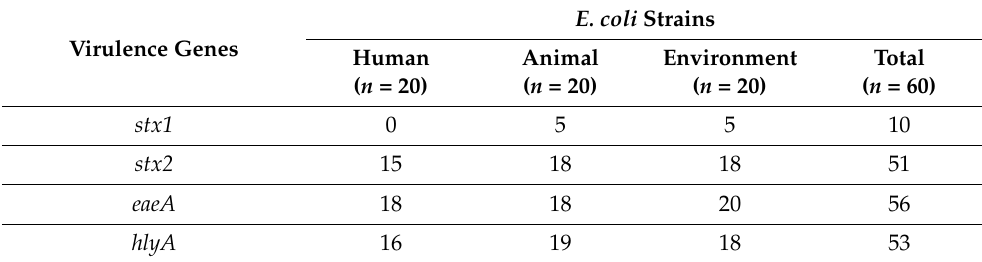
Table 2. Prevalence of virulence genes of human, animal, and environmental